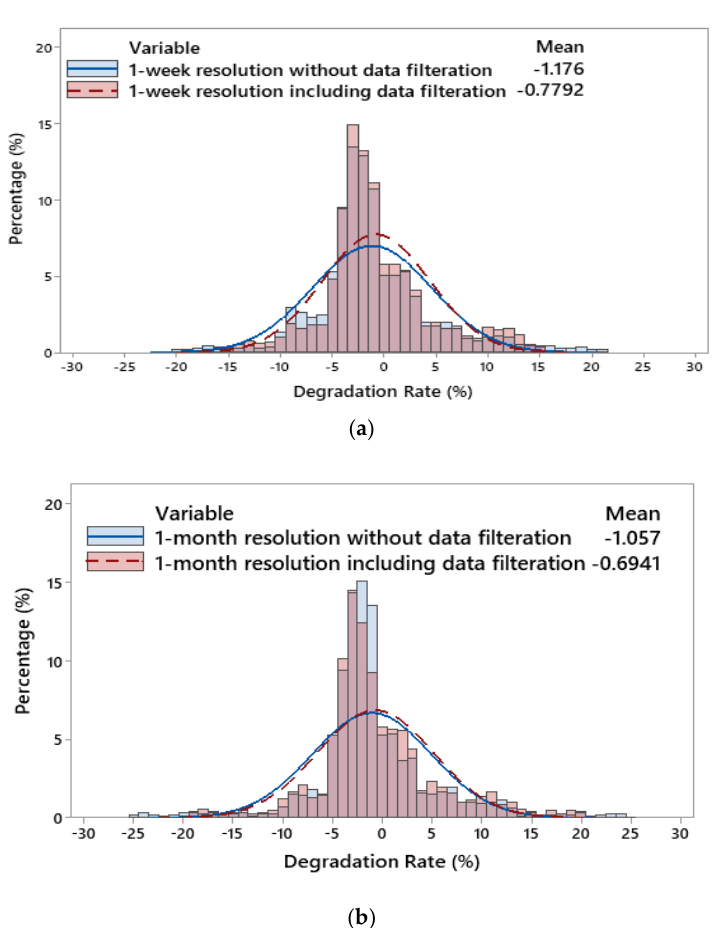
Figure 7. Degradation rate analysis for Plymouth city using RdTool [34]: ( a ) 1-week data resolution; ( b ) 1-month data resolution.